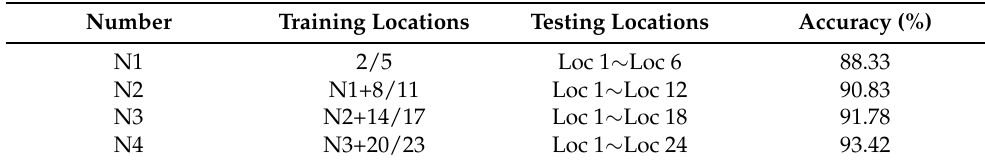
Figure 13. The confusion matrix of DCN-TL recognition accuracy. Table 7. The DCN-TL recognition accuracy of different sensing areas.